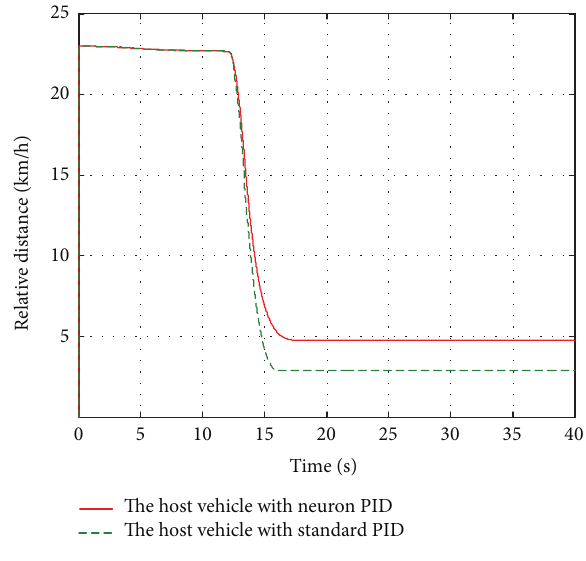
Figure 8: The relative